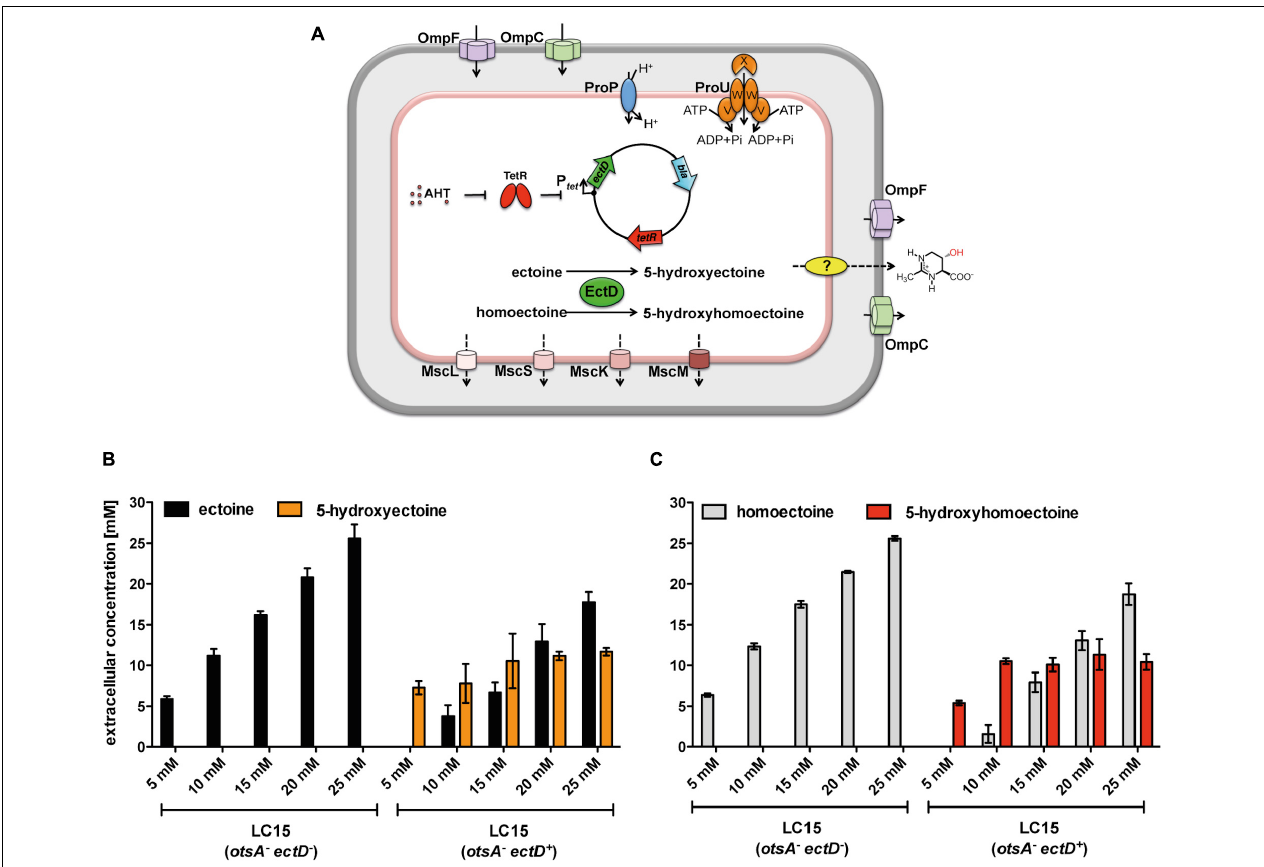
FIGURE 5 | Production of 5-hydroxyectoine or 5-hydroxyhomoectoine from ectoine or homoectoine in an E. coli strain expressing the ( Ps )EctD enzyme. (A) Schematic overview of the E. coli based EctD overproducing cell factory. The E. coli strain LC15 ( otsA :Tn 10 ) contained either the empty vector pASK-IBA3 (control) or the plasmid pMP41 ( ectD gene from P. stutzeri A1501) and was incubated in the presence of various concentrations of (B) ectoine or (C) homoectoine (ranging from 5 to 25 mM). The cultures were incubated for 24 h after induction of ectD expression with AHT in baffled flasks containing 10 ml of MMA containing 0.4 M NaCl. The concentrations of (B) ectoine/5-hydroxyectoine and (C) homoectoine/5-hydroxyhomoectoine within the supernatant were determined via HPLC analysis. The data shown represent the means and standard deviations of at least three independently grown cultures (two independently grown cultures for